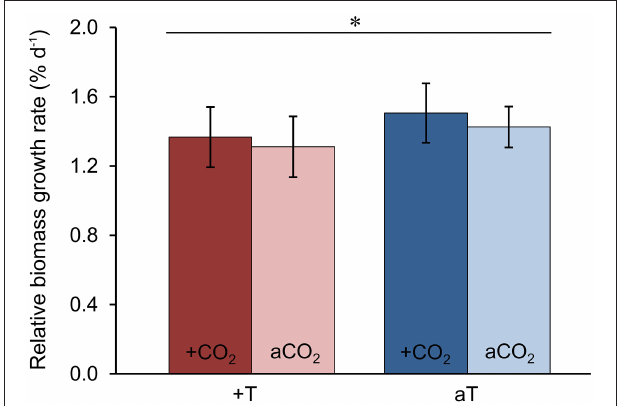
FIGURE 7 | Growth of Fucus mytili . Relative biomass growth rates in %d − 1 of F. mytili algae after 11 weeks of incubation in the benthic mesocosms under different conditions (see Section “Materials and Methods”; a, ambient; + , increased/elevated). Mean values ± SD ( n = 11) and asterisk ( p < 0.05 * ) indicates significantly different changes of growth rates (two-way ANOVA) driven by temperature effect ( p = 0.046 * , F = 5.58, dfn = 1, dfd =